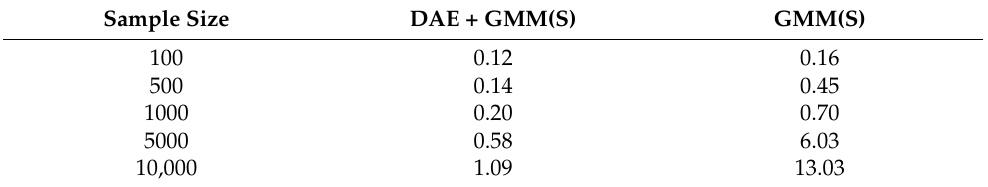
Table 2. Comparison of the clustering time of arrival trajectories in the two cases.